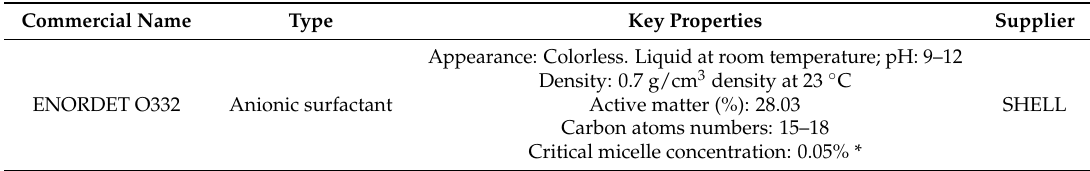
Table 2. Properties of IOS obtained from supplier and literature.